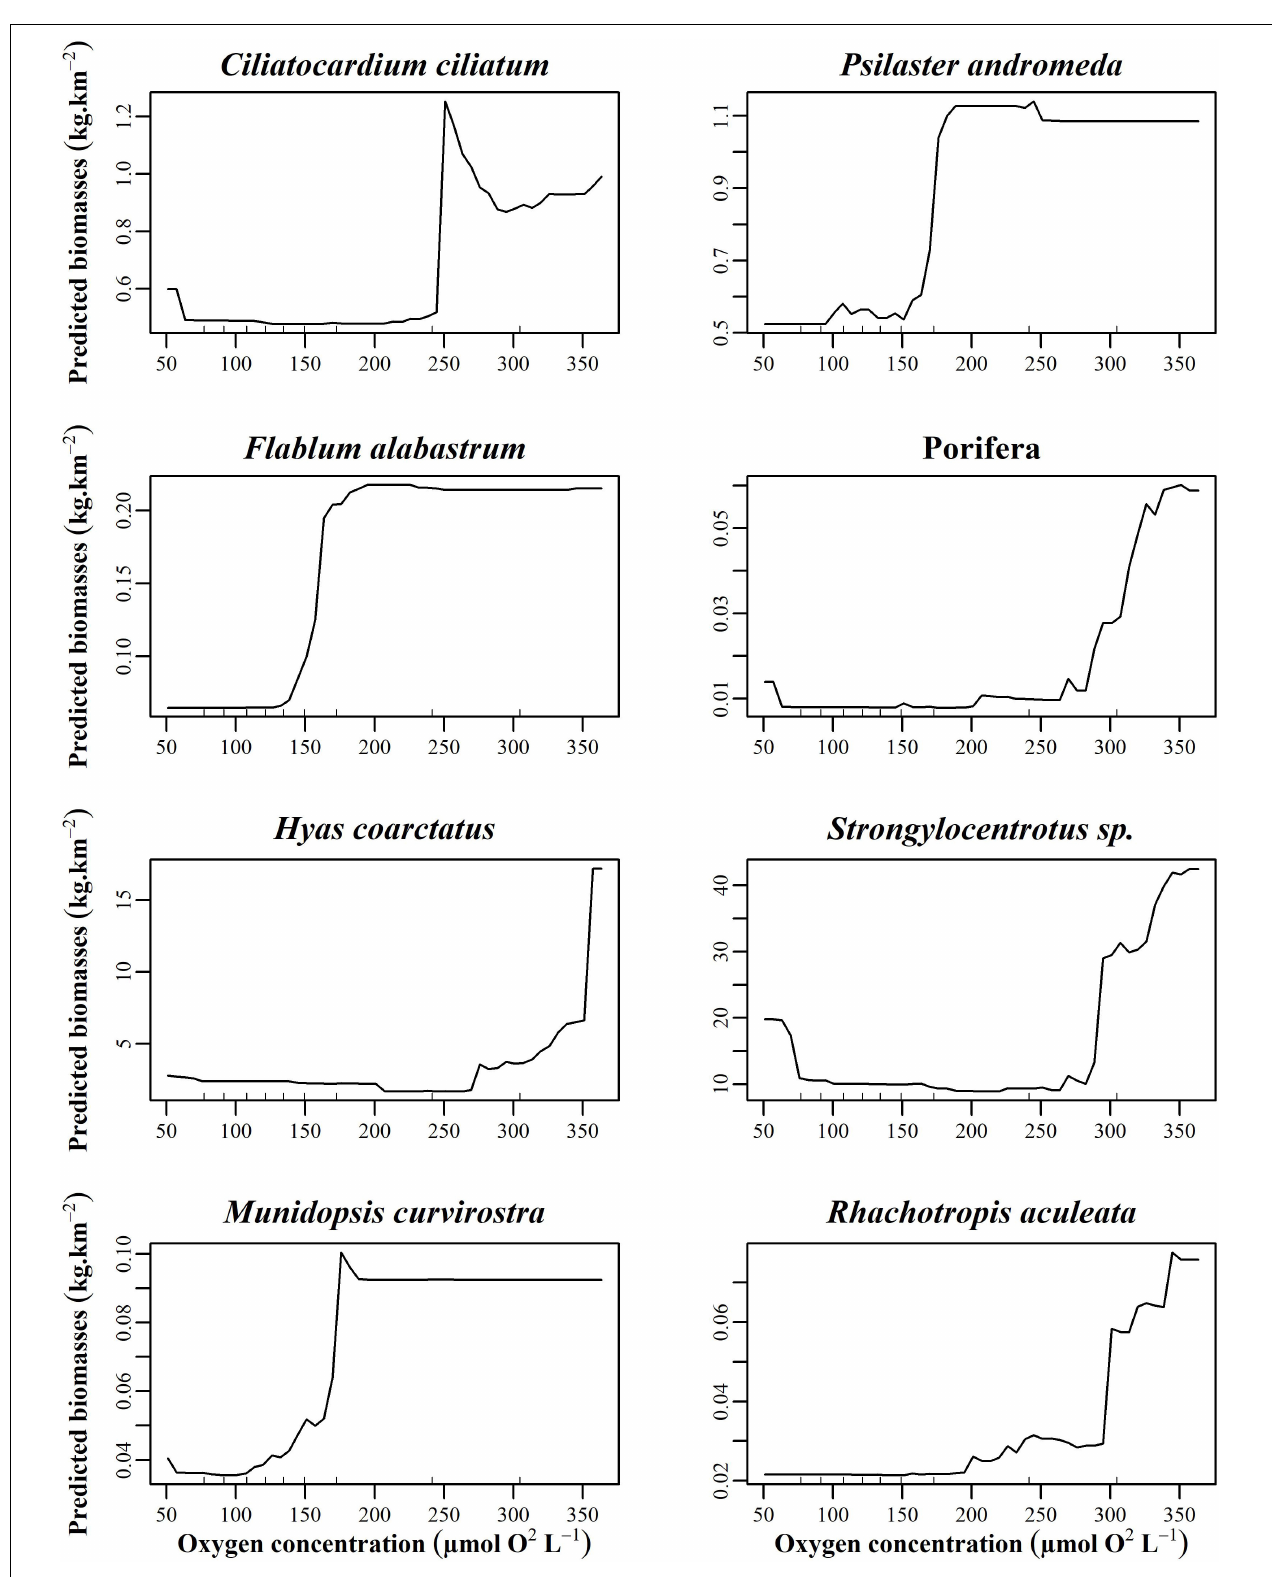
FIGURE 7 | Partial dependence plots of the top eight taxa with the highest R 2 from oxygen concentrations of 175–300 µ mol O 2 L - 1 thresholds build from the random forest biomass regressions of taxa for oxygen.